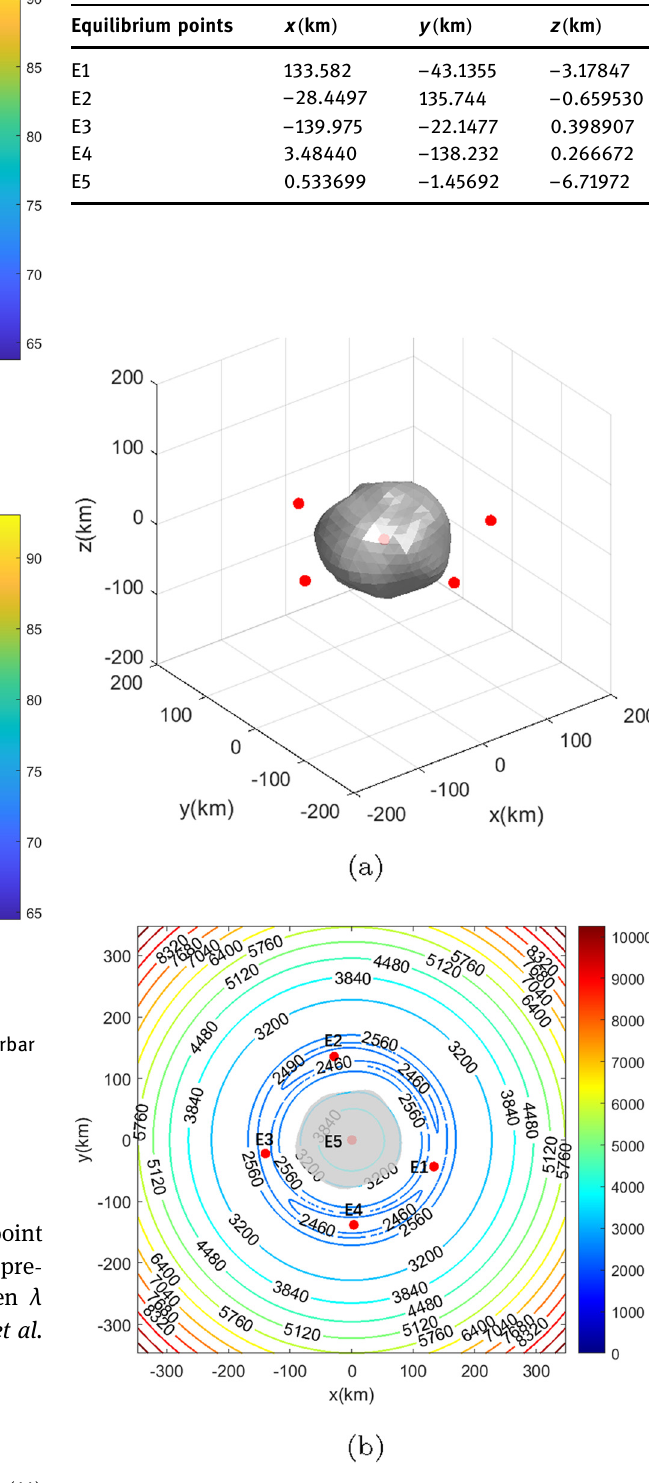
Figure 4: Locations of the equilibrium points of asteroid Minerva. ( a ) The positions of the equilibrium points in space. ( b ) Zero - velocity 0. curves and projections of the equilibrium points in the z +